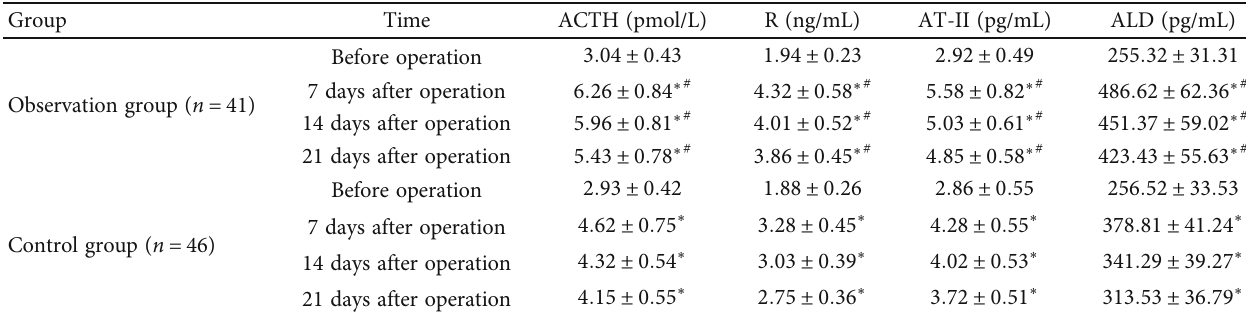
Control group ( n = 46 ) Values are presented as mean ± SD . ∗ P < 0 : 05 vs. before operation; # P < 0 : 05 vs. control group. ACTH: Adrenocorticotropin; R: Renin; AT-II: Angiotensin; ALD: Aldosterone. Table 3: Comparison of the content of immune cells in peripheral blood at di ff erent postoperative intervals. Group Time Observation group( n = 41